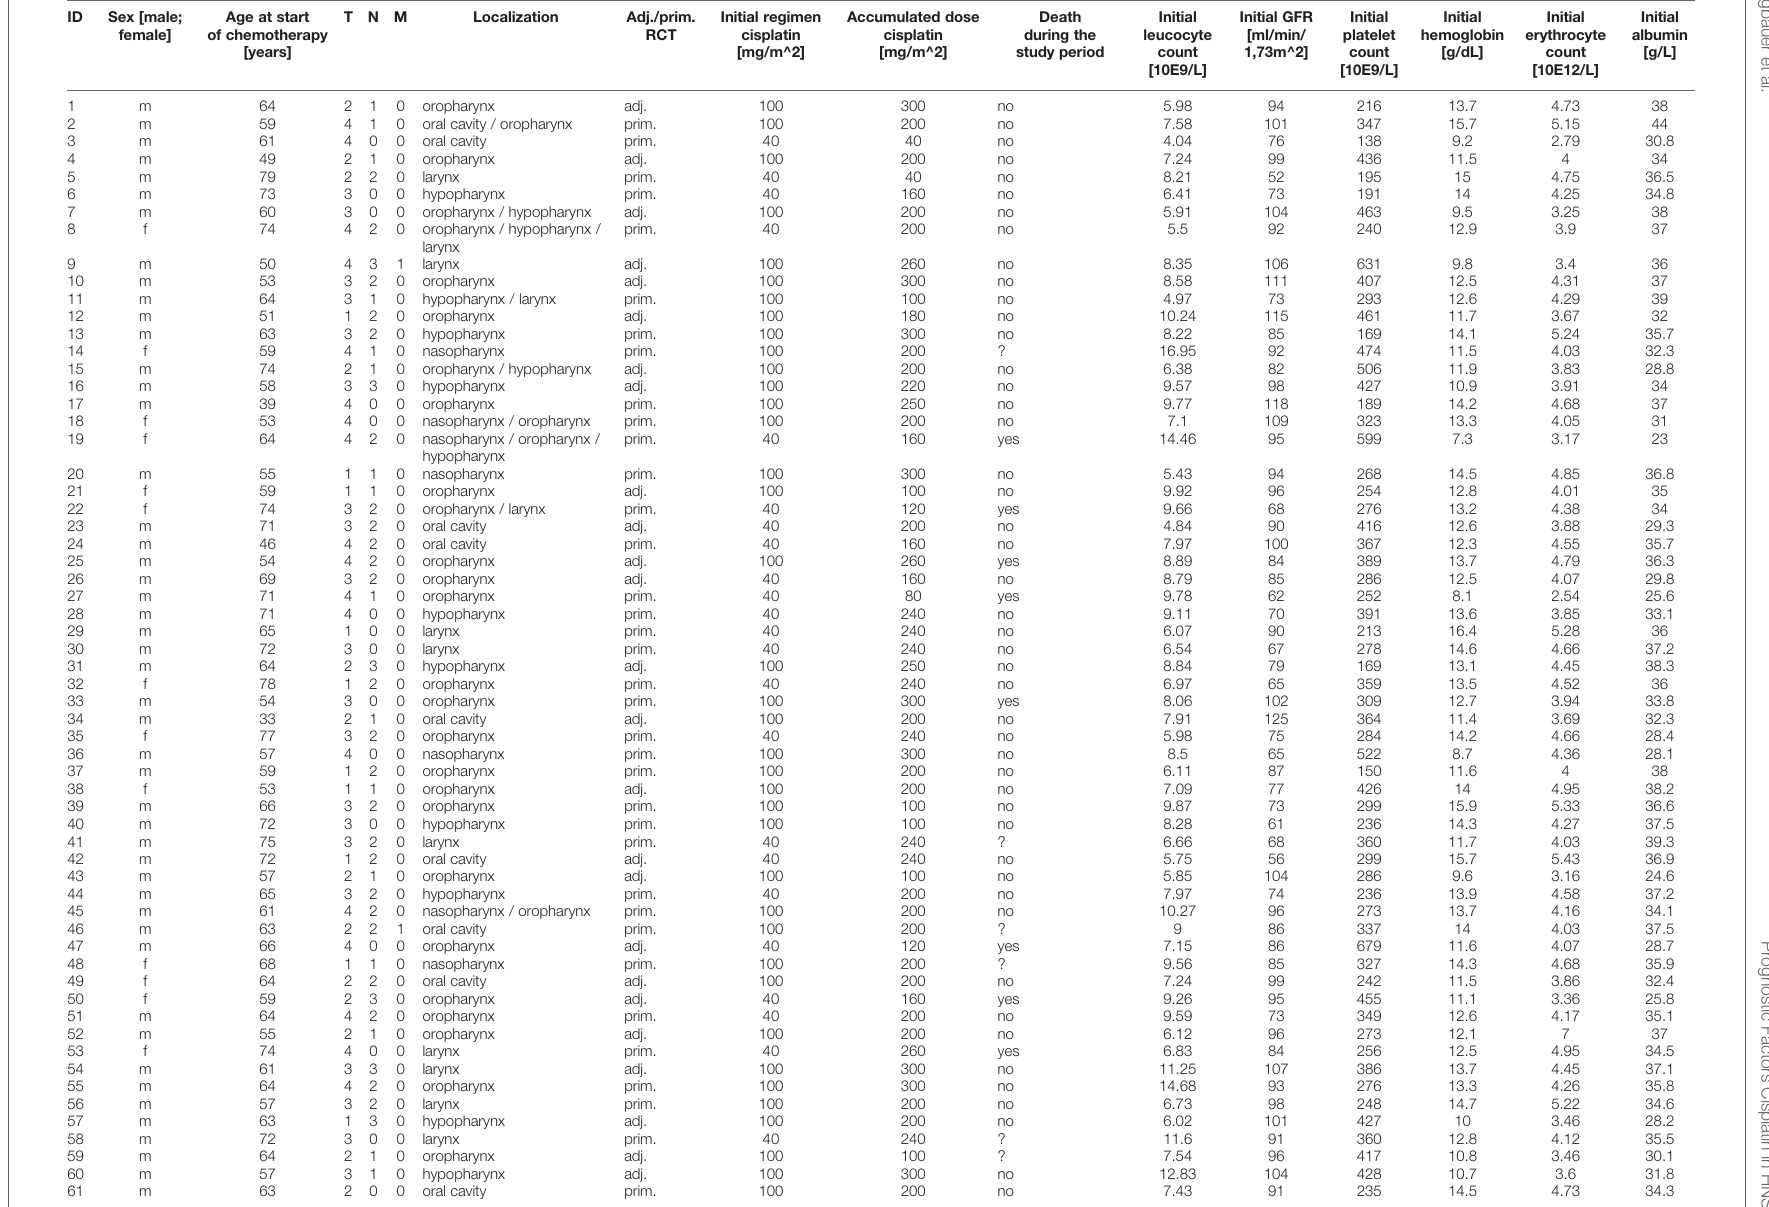
TABLE 1 | Characteristics and initial laboratory values of the examined patients (T, tumor extent; N, lymph node status; M, distant metastasis status). ID Sex [male; Age at start female] of